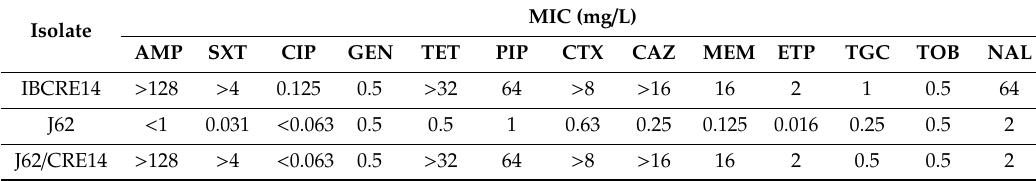
Table 1. Antimicrobial susceptibility profile of IBCRE14, the Escherichia coli J62, and the transconjugant J62 / CRE14 that harbours the plasmid (pIB_NDM_1).